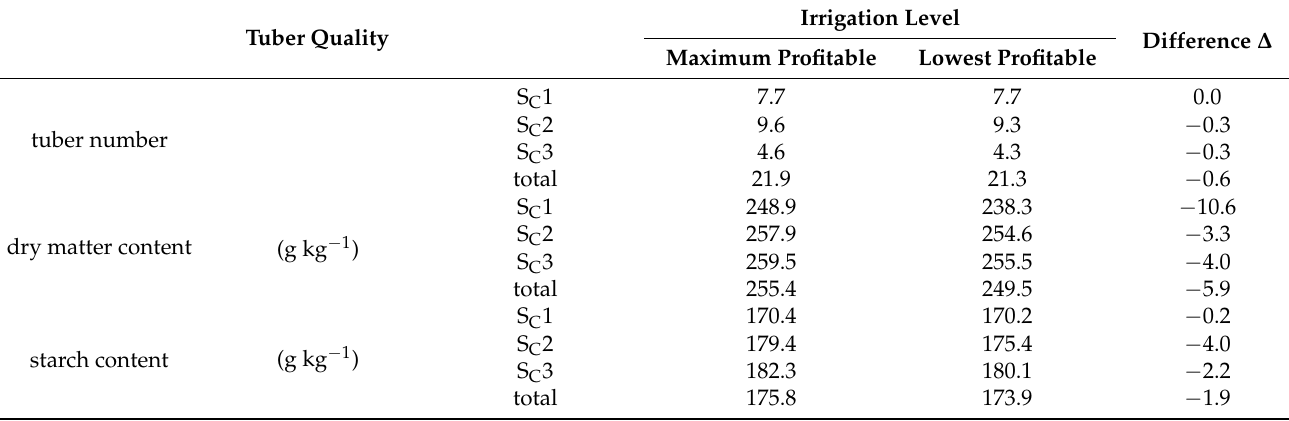
Table 7. Predicted changes in tuber quality when reducing the statistically maximum profitable irrigation level to the statistically lowest profitable irrigation level, for all tuber size